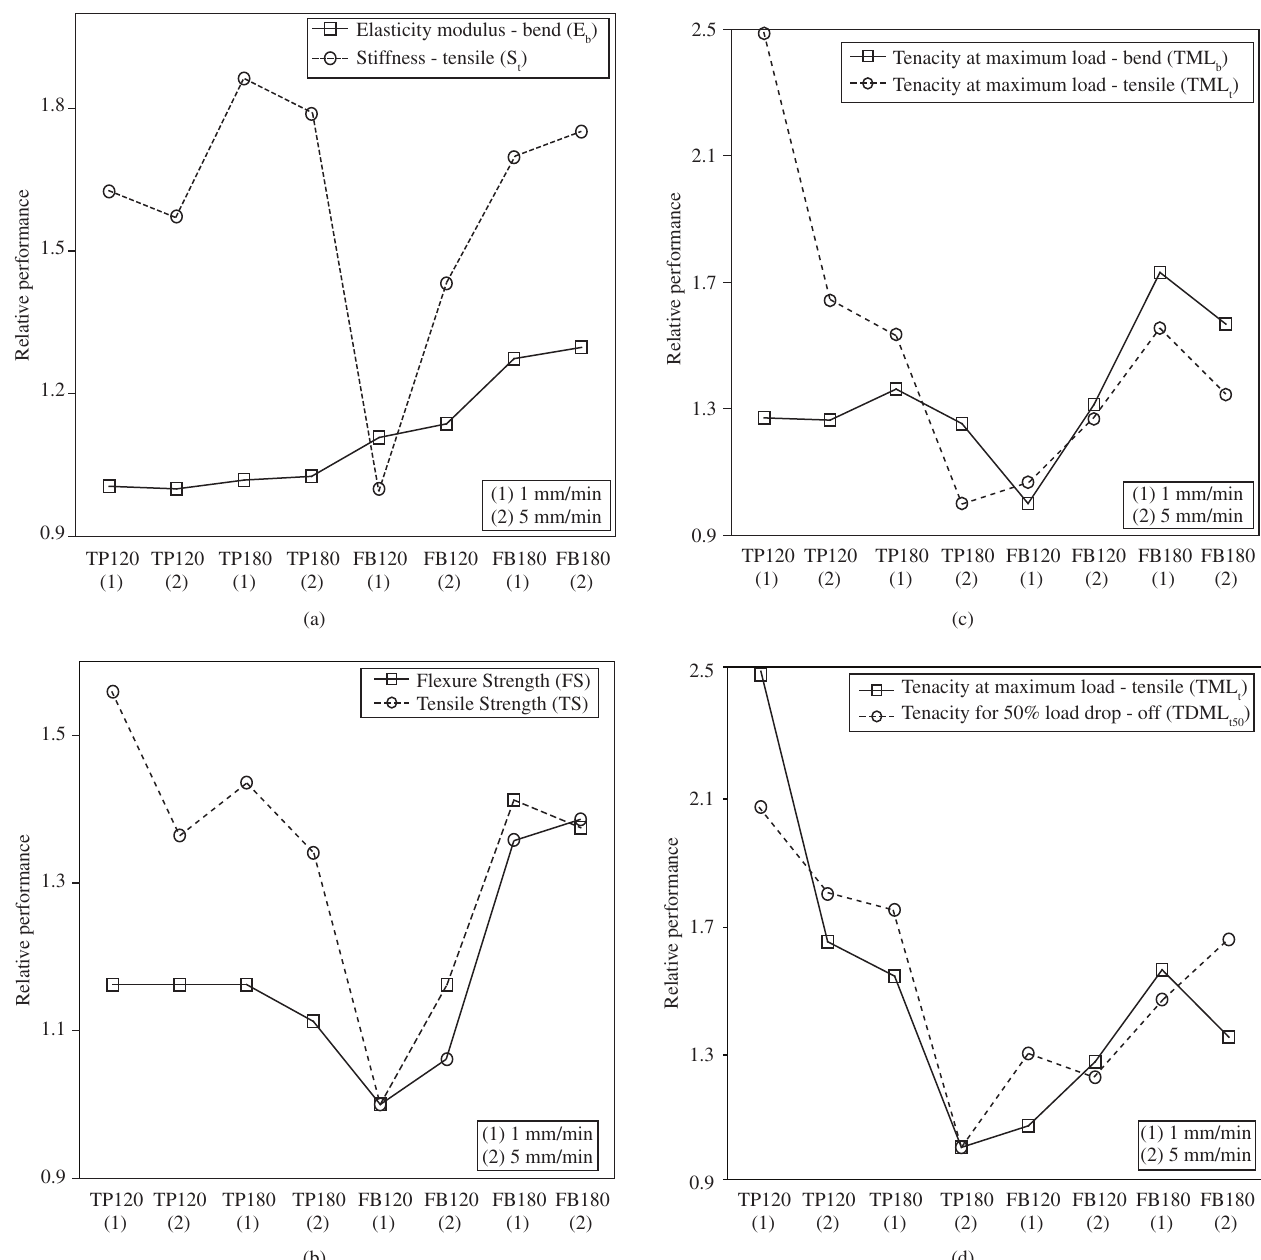
Figure 2. Relative performance of the materials (based on average results of Table 1) tested under tensile and three-point bend (Part I) loading conditions: vs . E a) S ; b) TS vs . FS; c) TML t f